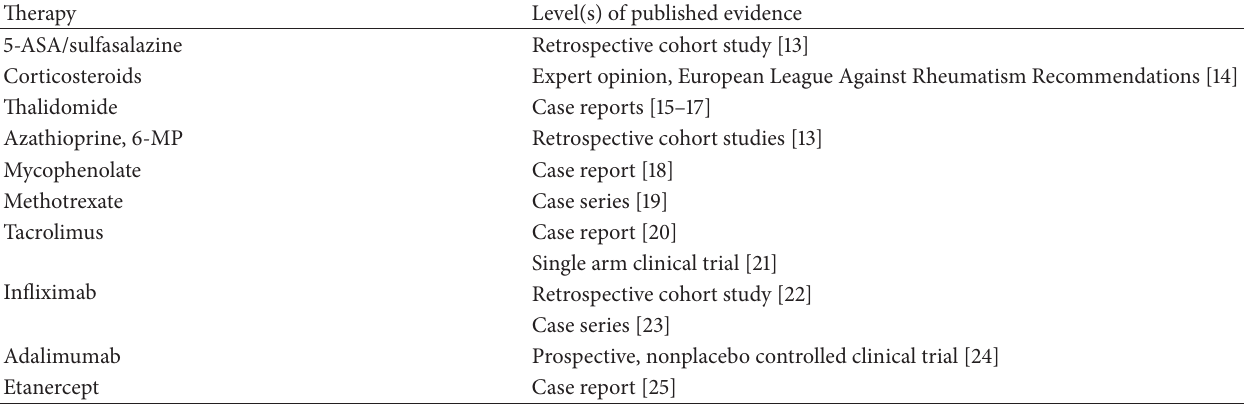
Table 1: Summary of the highest level of evidence for immunosuppressants and anti-TNF biologics